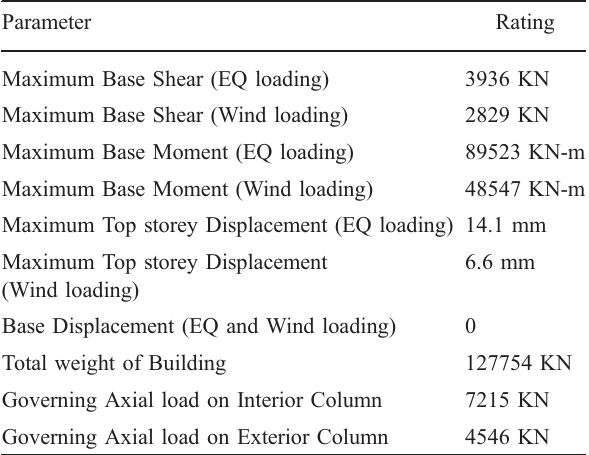
Table 1. Static analysis results (fixed base building) Parameter Rating